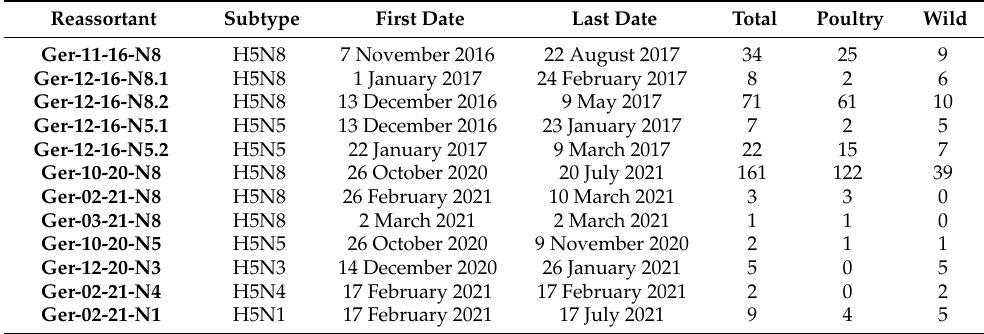
Table 1. Metadata of reassortants regarding subtype, first and last identification date, number of overall sequenced cases/outbreaks followed by poultry and wild bird sequence counts.